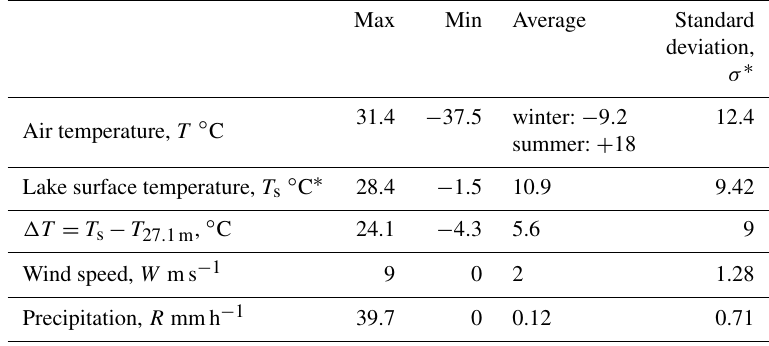
Table 1. Hydrometeorological conditions during the period 14 July 2010–19 October